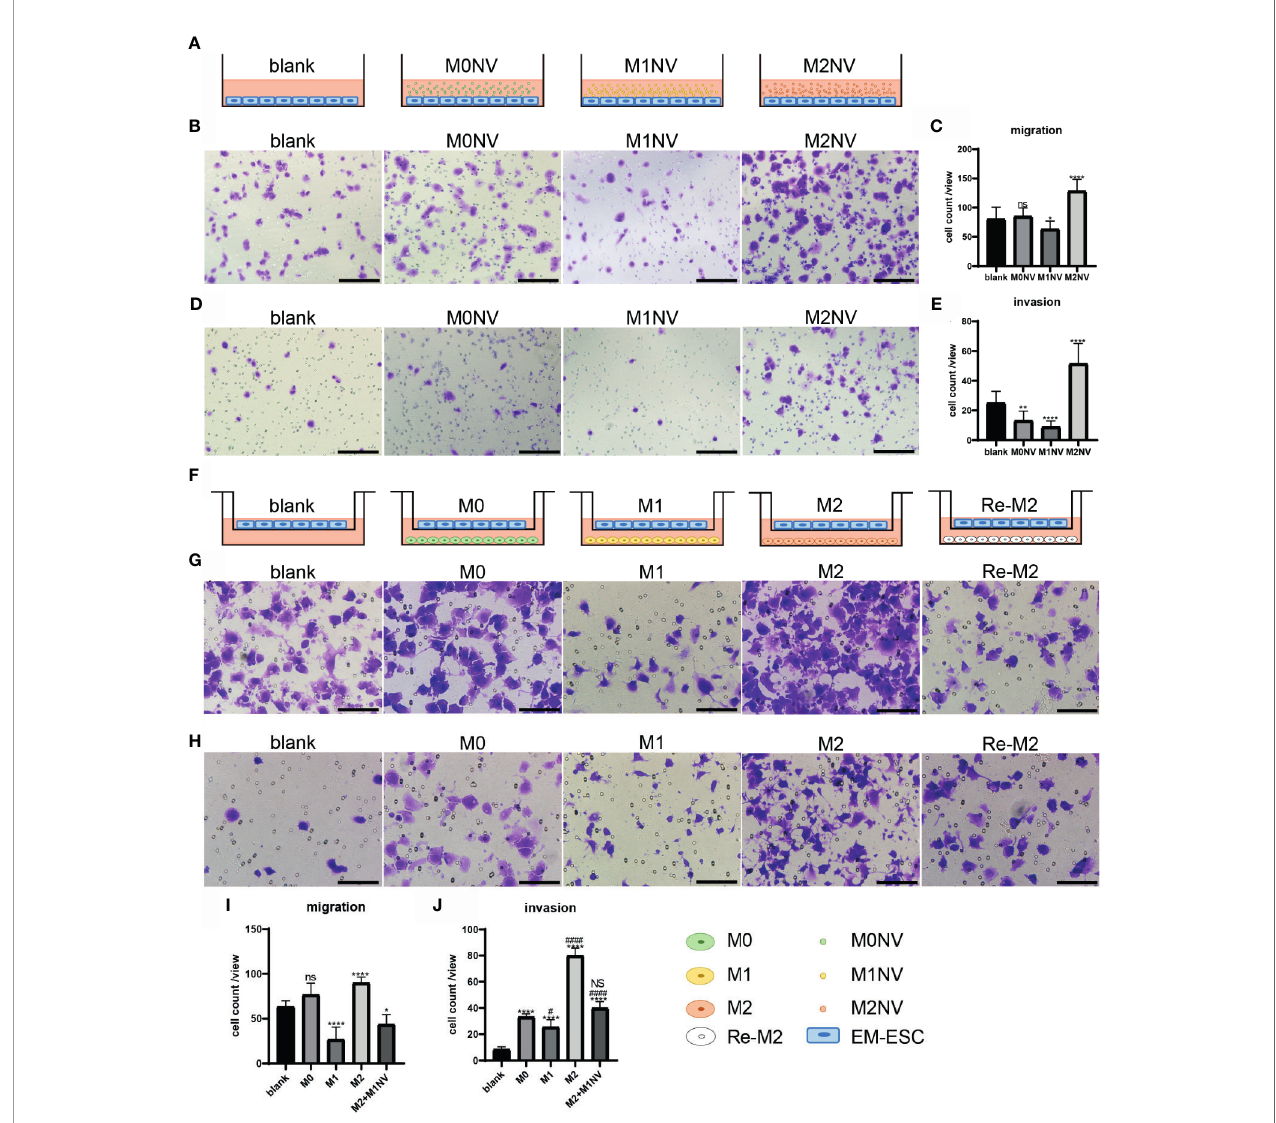
FIGURE 3 | M1NVs could inhibit the migration and invasion of EM-ESCs directly or through reprogramming of M2 macrophages. (A, F) Co-culture pattern diagram of the migration and invasion assays. (B – E) Migration (B, C) and invasion (D, E) of EM-ESCs treated with NVs derived different type of macrophages, and M1NVs could inhibit the migration and invasion of EM-ESCs (Scale bar =100 m m). (G – J) Migration (G, H) and invasion (I, J) of EM-ESCs treated by different type of macrophages (Scale bar =100 m m). (ns: no signi fi cance when compared with blank. NS: no signi fi cance when compared with M0. *P<0.05; **P<0.01, ****P<0.0001 when compared with blank. # P<0.05; #### P<0.0001 when compared with M0